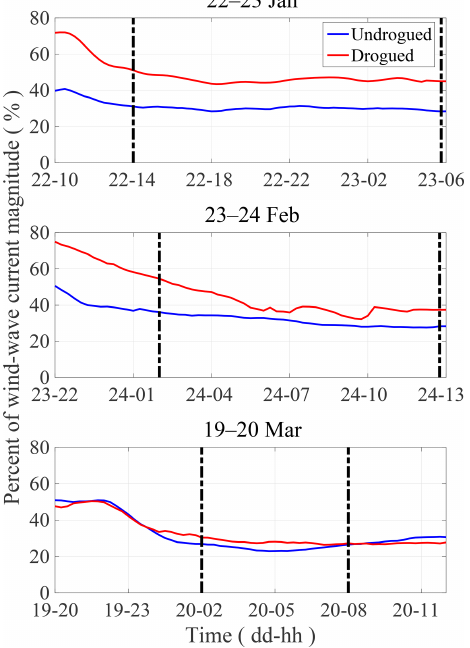
Figure 12. Average of the Eulerian LAVA-derived velocity field es- timates of the pre-wind event regional circulation plotted as a per- centage in time of the average combined wind- and wave-driven flow for drogued and undrogued drifters. Dashed vertical lines de- pict the analysis period for the total velocity deconstruction.